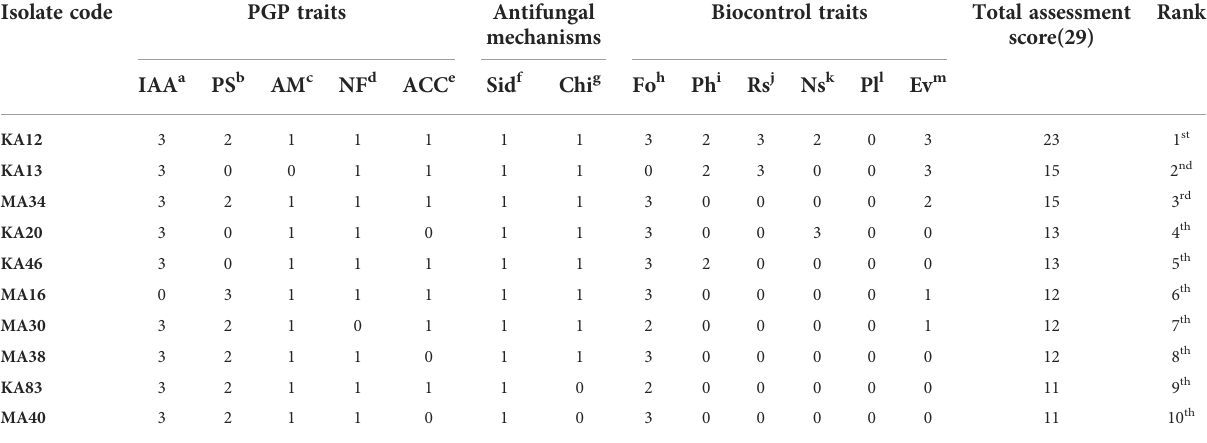
TABLE 4 Bonitur ranking of top 10 endophytic actinobacteria associated with tea with PGP and biocontrol traits. Isolate